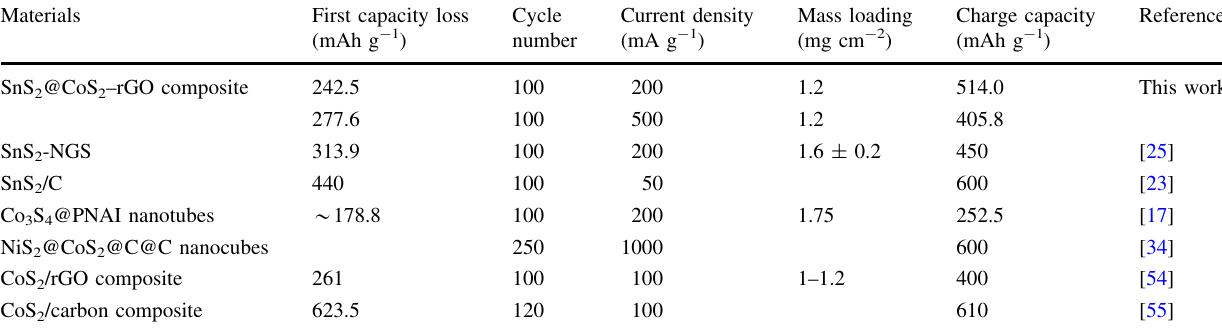
Table 1 Comparison of the Na-storage performance of reported tin sulfide and cobalt sulfide-based materials